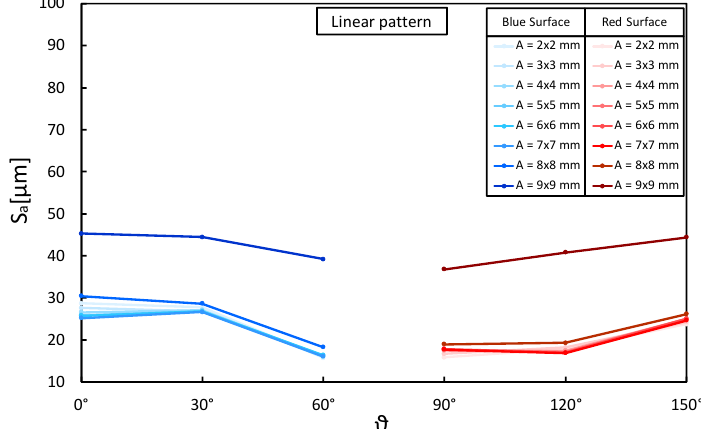
Figure 5. Preliminary measurements on A 1, A 4, and A 7 specimens: evaluation of S a parameter in function of definition area ( A ) and building angle ( θ ).